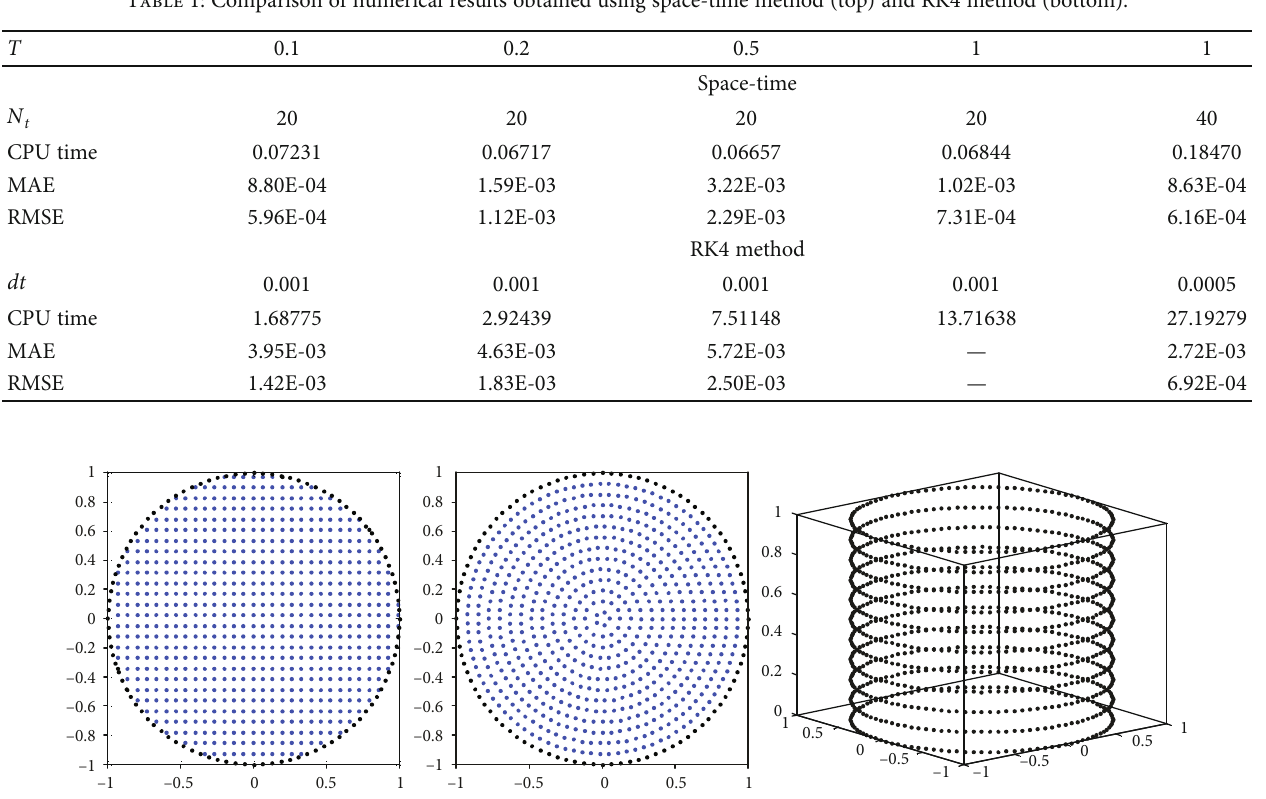
Figure 4: Uniform and circular distributions of nodes for the 2D space domain and the 3D space-time